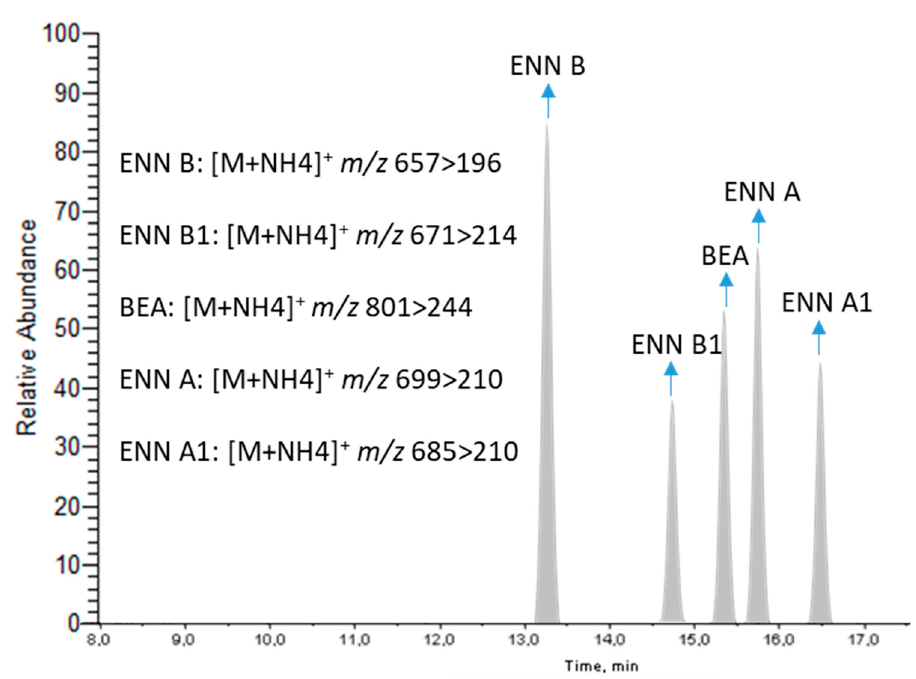
Figure 2. The LC-MS/MS Chromatogram for Target Emerging Fusariotoxins at a Concentration of 10xLOQ.